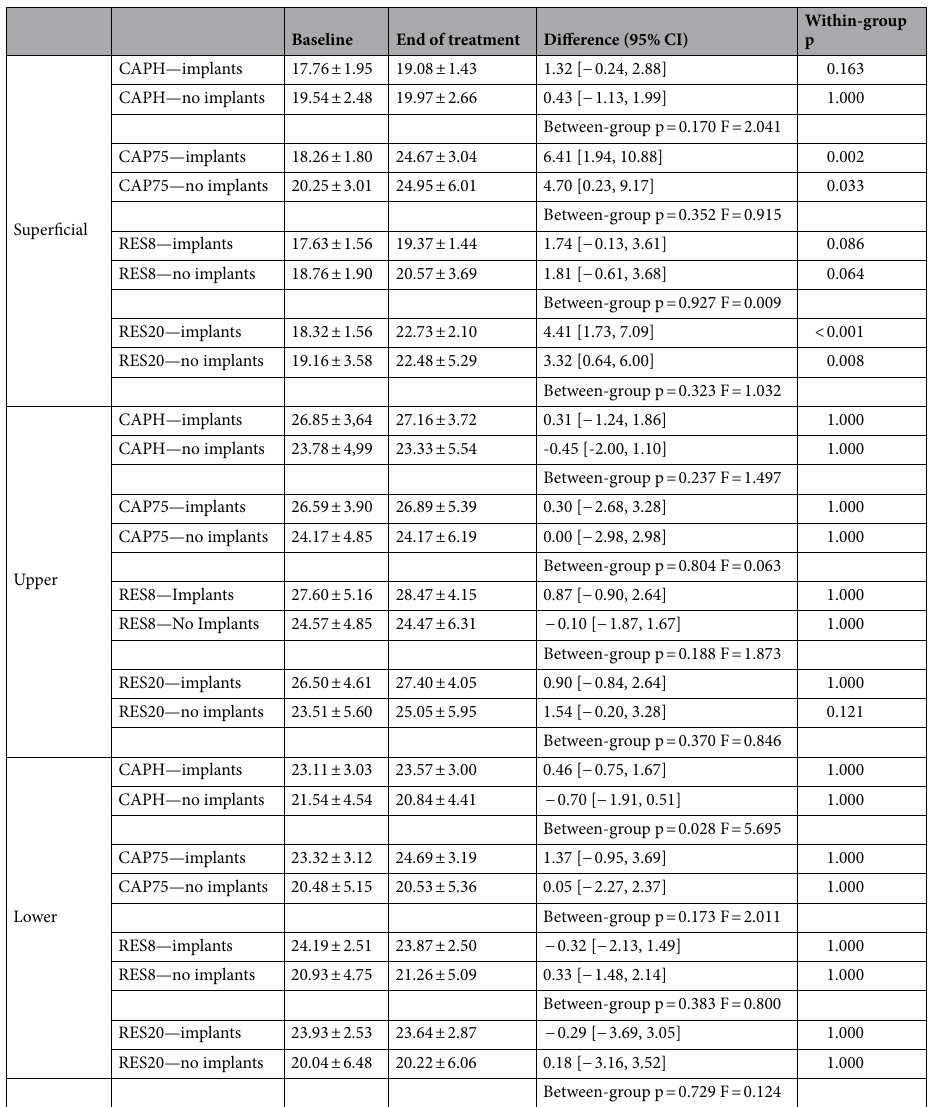
Table 2. Molar with and without implants. CI confidence interval, CAPH capacitive hypothermic, CAP75 capacitive 75 VA, RES8 resistive 8 watts, RES20 Resistive 20